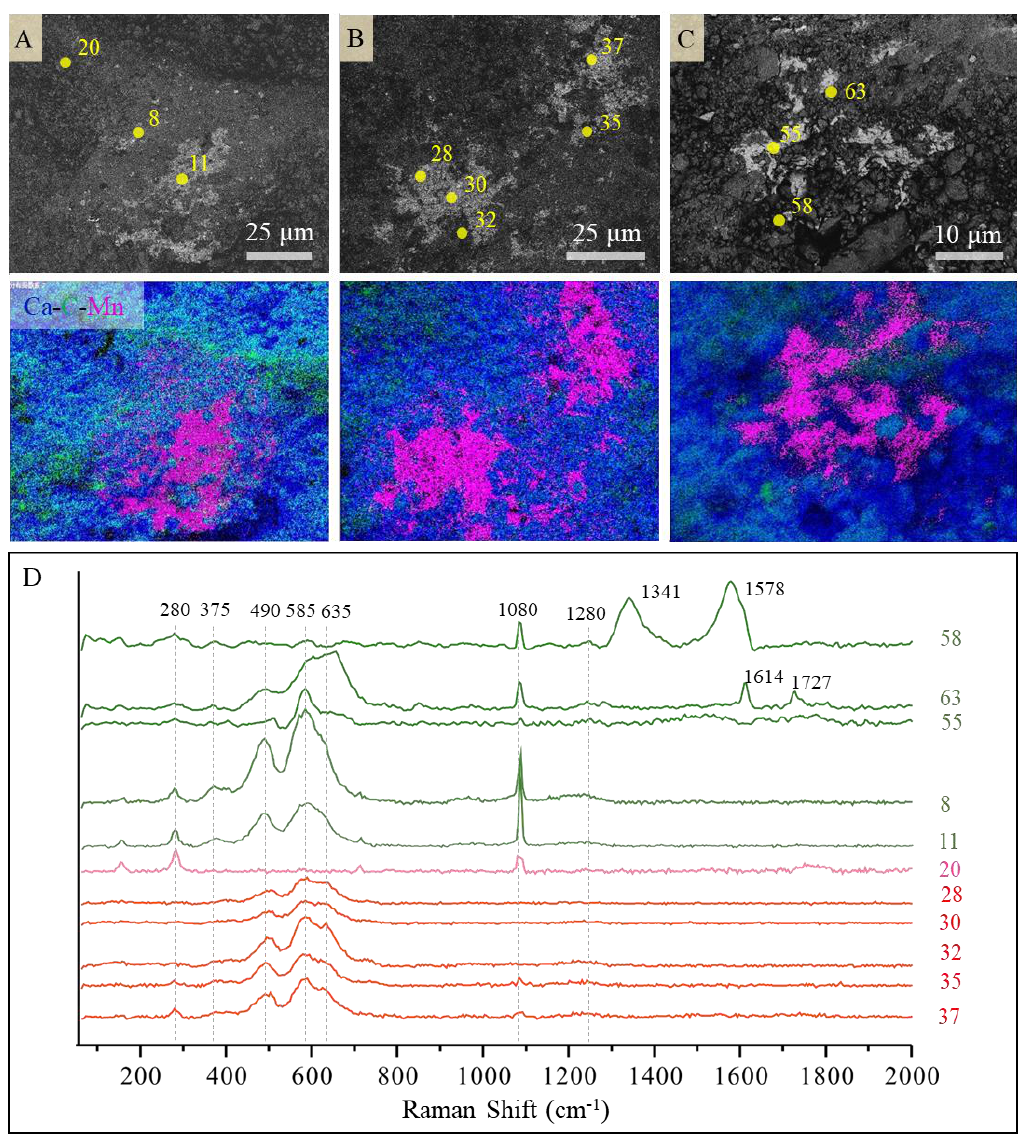
Figure 8. Combined backscattered electron SEM (SEM-BSE) and elemental mapping image and selected area Raman spectra were acquired on three fractured rock samples. ( A – C ) The upper images show the SEM-BSE images and the lower images show the distribution of Ca, Mn and C in the same area. EDS mapping images were merged in the software Image J. Numbers indicate the points where Raman spectra shown in ( D ) were acquired.